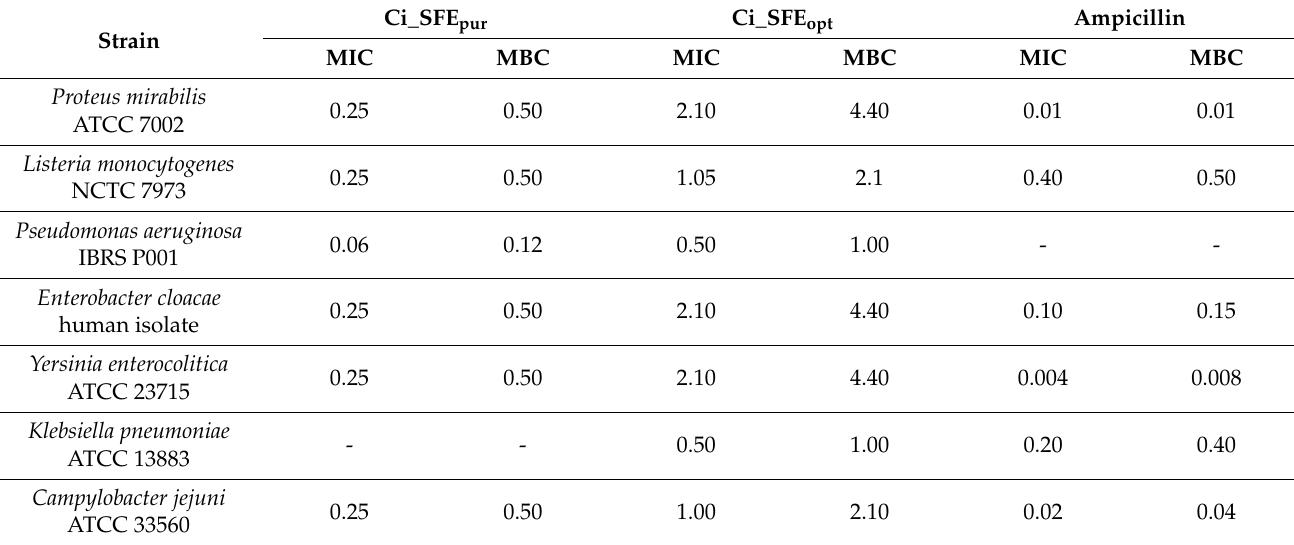
Table 4. Antibacterial activities of Ci_SFE pur and Ci_SFE opt (mg/mL). MIC, minimal inhibitory concentration; MBC, minimal bactericidal